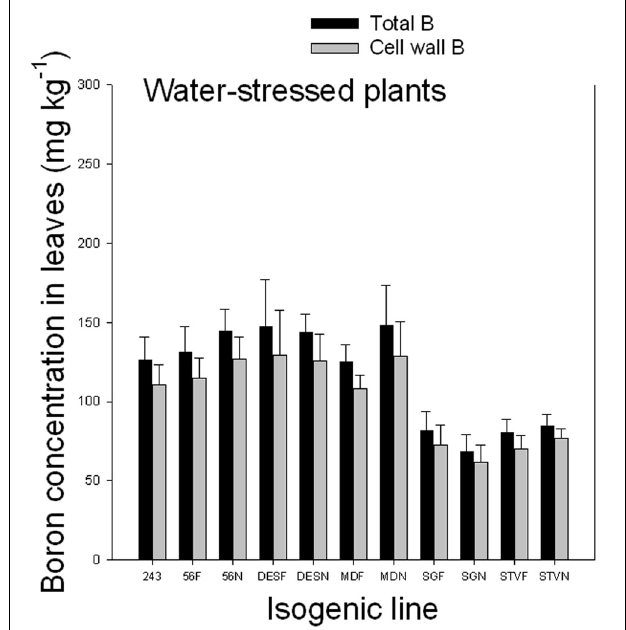
FIGURE 3 | Total and cell wall boron in leaves as affected by near isogenic mutant lines for fuzzless seed trait under water stressed conditions. In each isogenic line, F refers to a fuzzy line and N refers to its equivalent fuzzless line. Since the experiment was repeated twice and the results were pooled and combined, bar values are mean of eight replicates ± SE (standard error of the